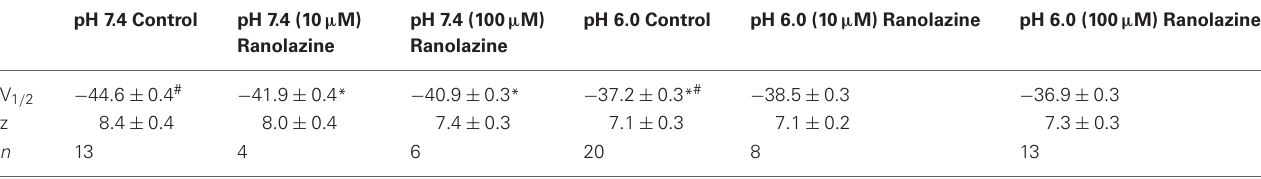
Table A1 | Conductance.